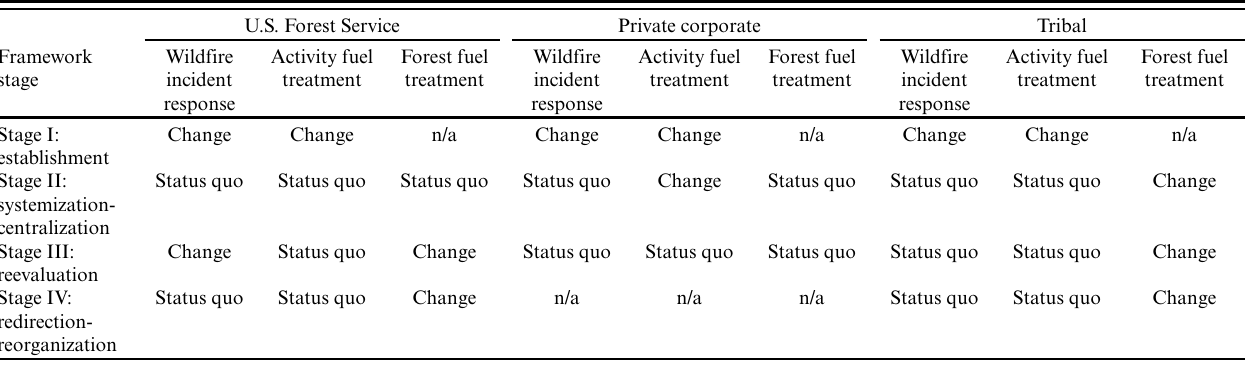
Table 4. Summary of wildfire management change or status quo by ownership group across historical framework stages. “Change” indicates a management shift from the status quo (during stage I, “change” indicates the introduction of management practices). “Status quo” indicates that the status quo is maintained relative to the previous